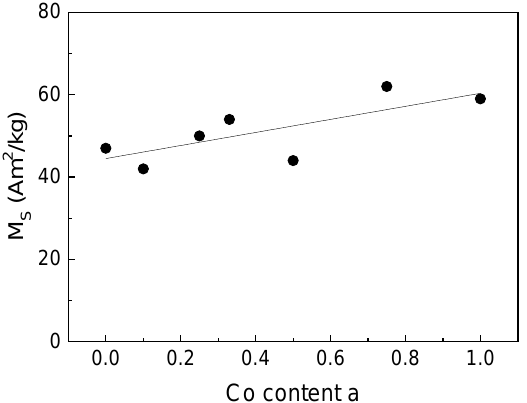
Figure 5. Saturation magnetization (M S ) of powders of bare magnetic particles as function of Co content of the partices, measured by means of VSM at H = 1275 kA/m, the line serves as a guide to the eye only.